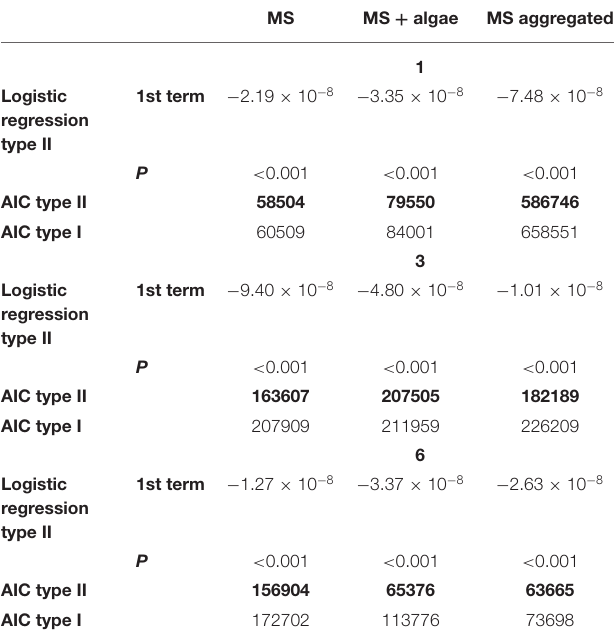
TABLE 3 | The results of logistic regressions for the selection of type II are shown, together with the Akaike information criterion (AIC) values for fitted type II (see Equation 1 in the text) and type I functional response models for three sizes of MS (1, 3, and 6) and the treatments (MS, MS + algae, and MS